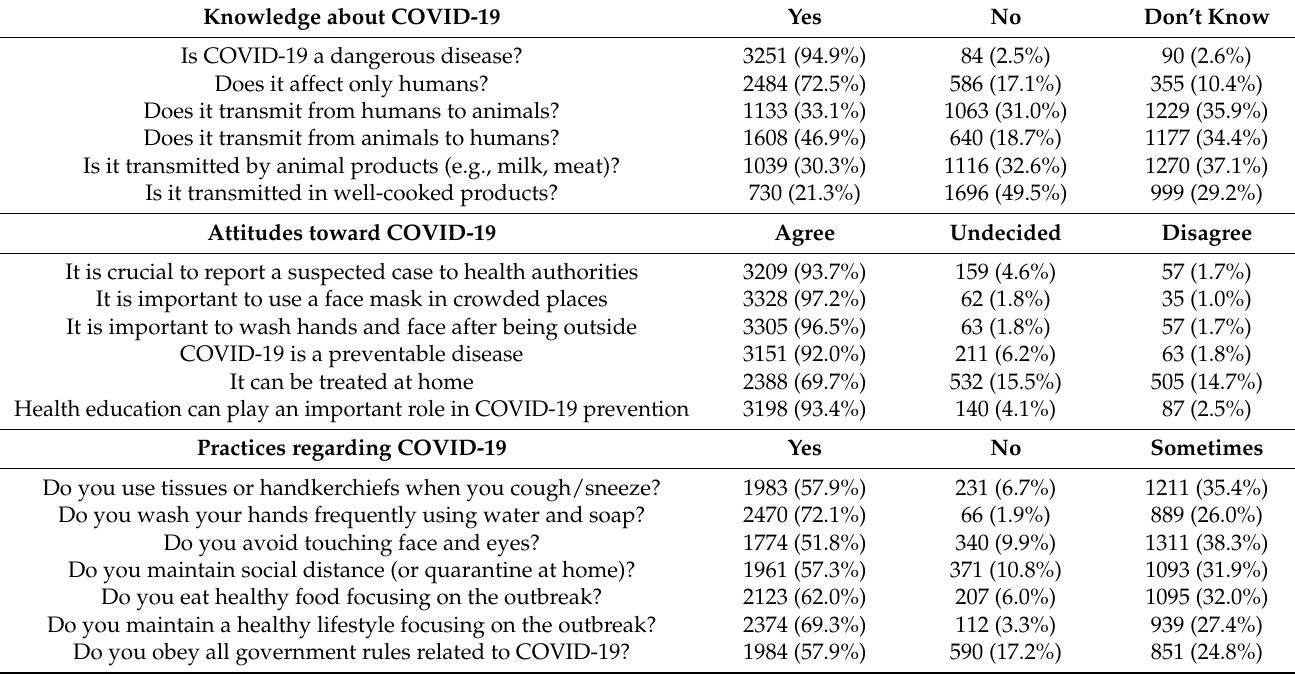
Table 3. Knowledge, attitudes and practices regarding